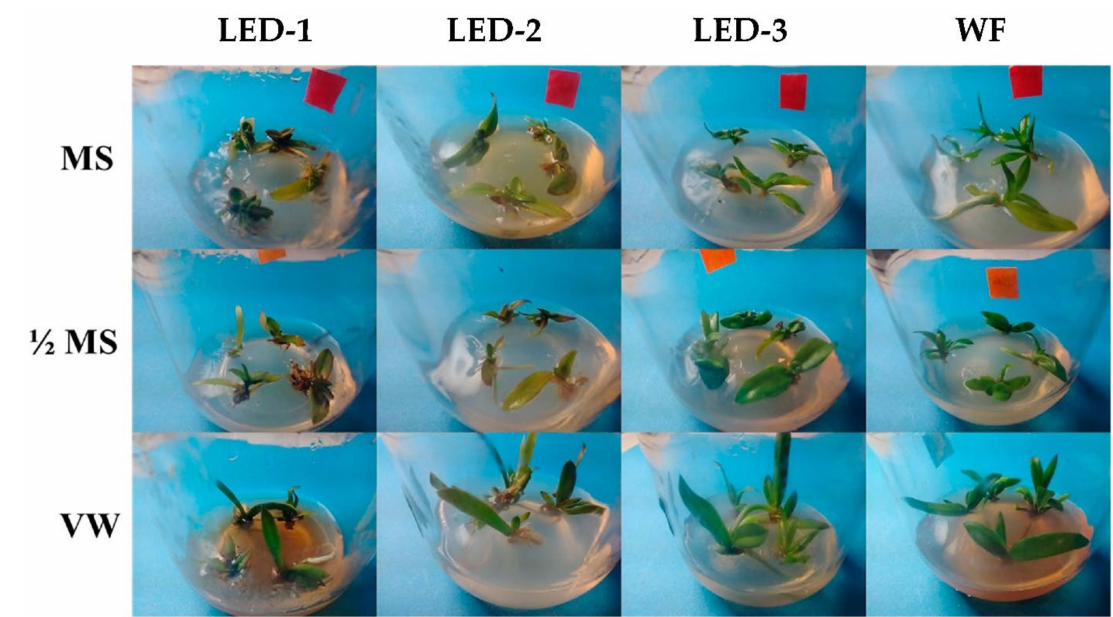
Figure 2. Effects of light sources and culture media on micropropagation of B. nodosa after 60 days of culture establishment. LED-1: Light-emitting diode (LED) light with 1575 ± 50 µ mol m − 2 s − 1 Pho- tosynthetic Photon Flux Density (PPFD); LED-2: LED light with 1015 ± 50 µ mol m − 2 s − 1 PPFD; LED-3: LED light with 80 ± 5 µ mol m − 2 s − 1 PPFD; and WF: white fluorescent light with 50 ± 5 µ mol m − 2 s − 1 PPFD. MS: MS basal medium supplemented with 30 g L − 1 sucrose and 7 g L − 1 agar; 1 / 2 MS: half-strength MS basal medium supplemented with 15 g L − 1 sucrose and 7 g L − 1 ; VW: VW basal medium supplemented with 10% coconut water, 20 g L − 1 sucrose and 7 g L − 1 .